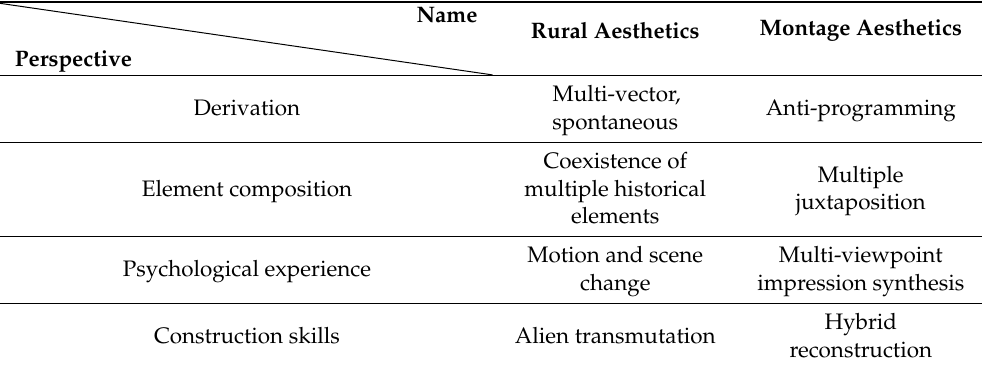
Table 2. Montage aesthetics and rural